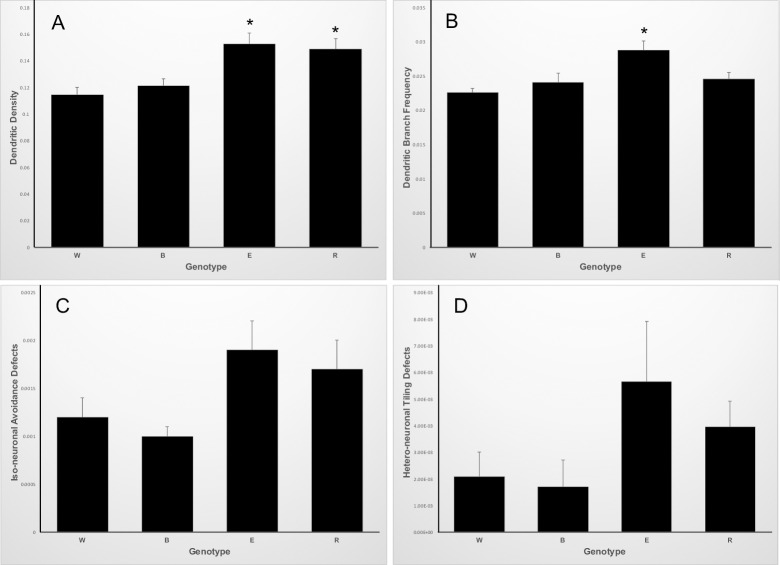
Quantification of ddaC dendrite morphologies in control, mutant and rescued third instar larvae.Genotypes in all panels: W, wildtype larvae, N = 9; B, trio-mutant background, N = 8; E, seq-enhanced trio mutants, N = 9; R, class IV da trio expression in the seq-enhanced trio mutant background, N = 10. Error bars represent the standard error of the means. (A) Dendritic density (dendrite length in μm/μm2 surface). ANOVA p-value = 0.0005; E and R are not statistically different from each other, but both are statistically different from both W and B at p<0.05. (B) Dendritic branch frequency (dendritic branches/dendrite length in μm). ANOVA p-value = 0.0022; E is statistically different than W, B and R at p<0.05. (C) Iso-neuronal avoidance defects (iso-neuronal avoidance defects/dendrite length in μm). ANOVA p-value = 0.086. (D) Hetero-neuronal tiling defects (hetero-neuronal tiling defects/μm of path length of interface between dendritic fields). ANOVA p-value = 0.197.